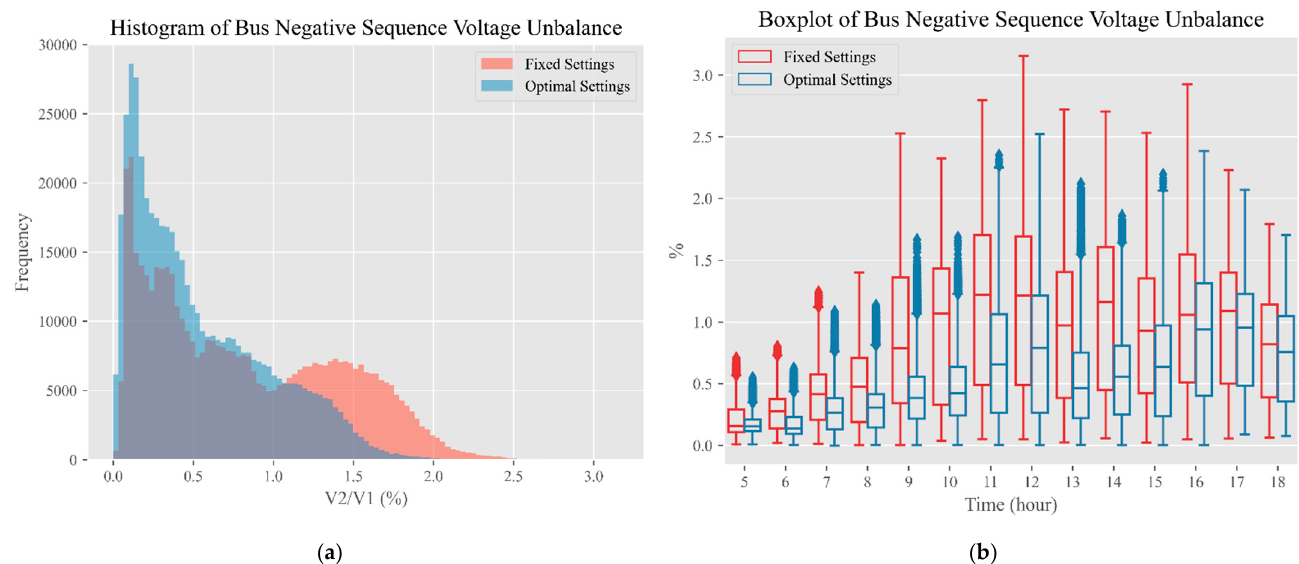
Figure 12. Negative sequence voltage unbalance: ( a ) Histogram; ( b )